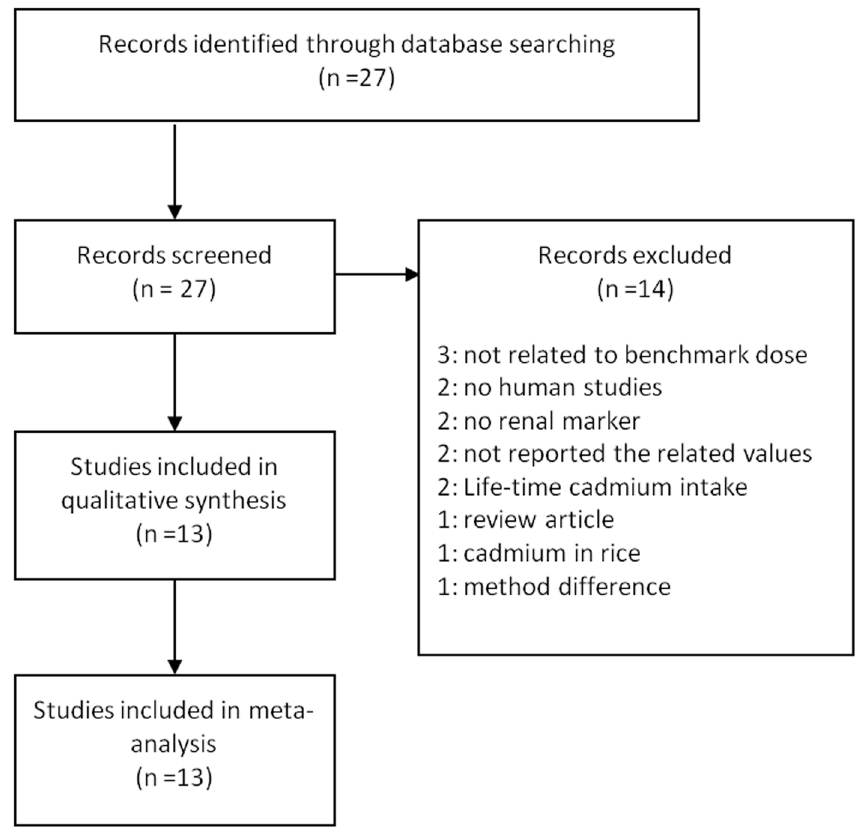
Fig 1. Flow diagram of the study selection